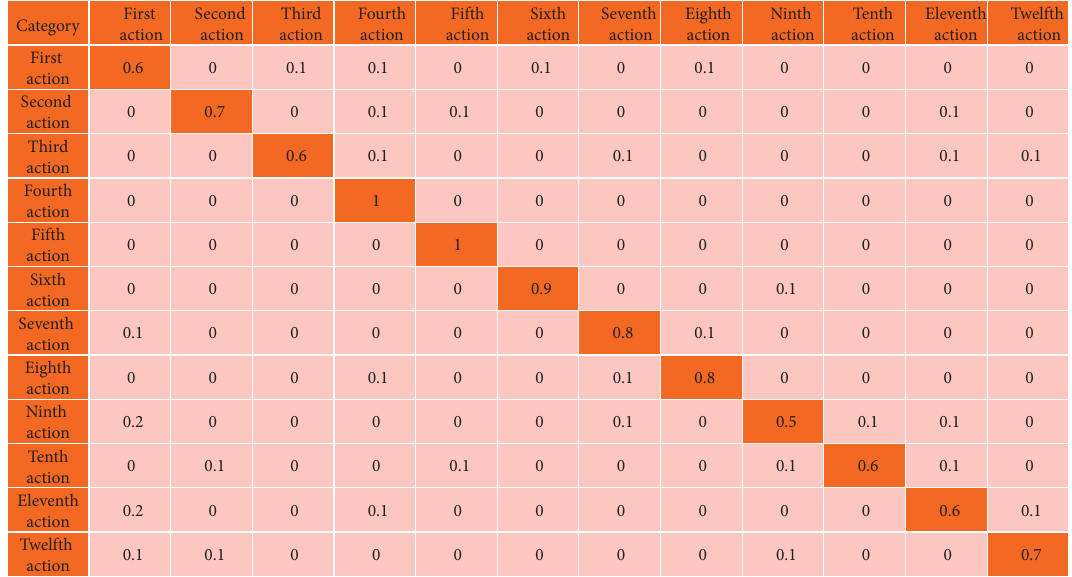
Figure 10: Confusion matrix of LWCNN in Exercise